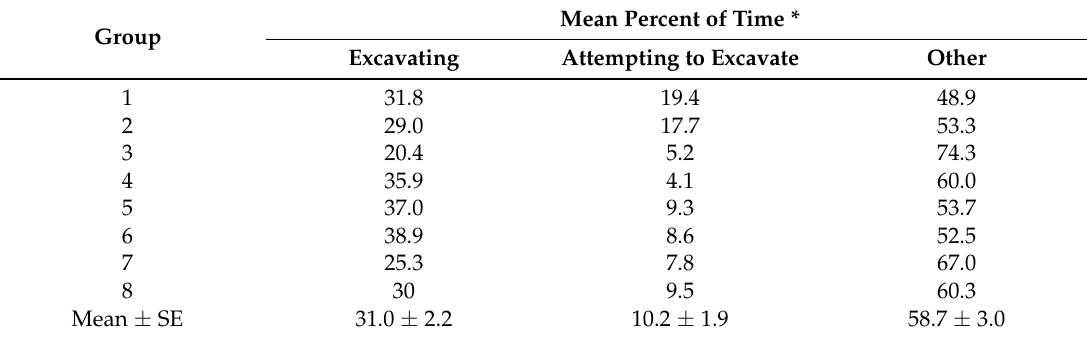
Percent of time spent excavating and in other activities by groups of neonates of Cactoblastis cactorum